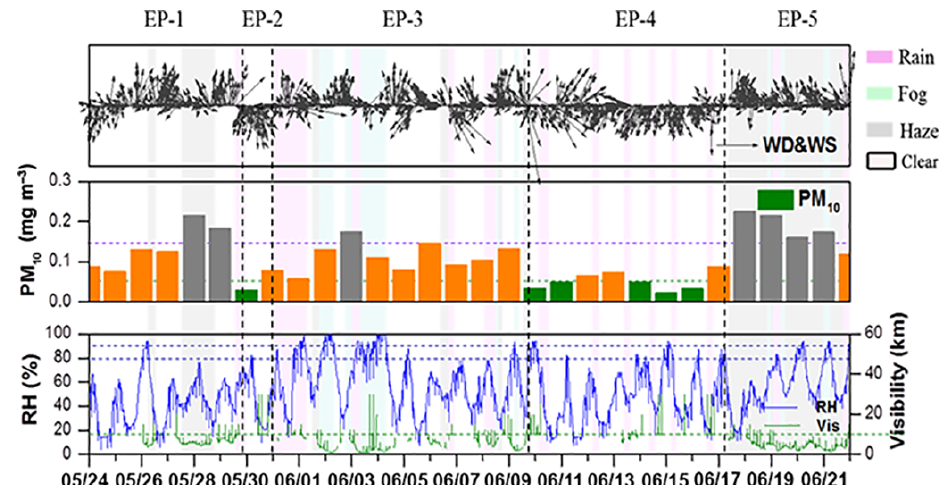
Figure 1. Categorization of five episodes. EP-1 features haze caused mainly by transportation of southern industrial pollution; EP-2 is clear, EP-3 has a frequent transition among haze, fog and clear conditions; EP-4 is mainly clear with rain interrupting; and EP-5 haze resulted mainly from the biomass burning (brown, green, and orange colours mean the haze, clear, and fog conditions,